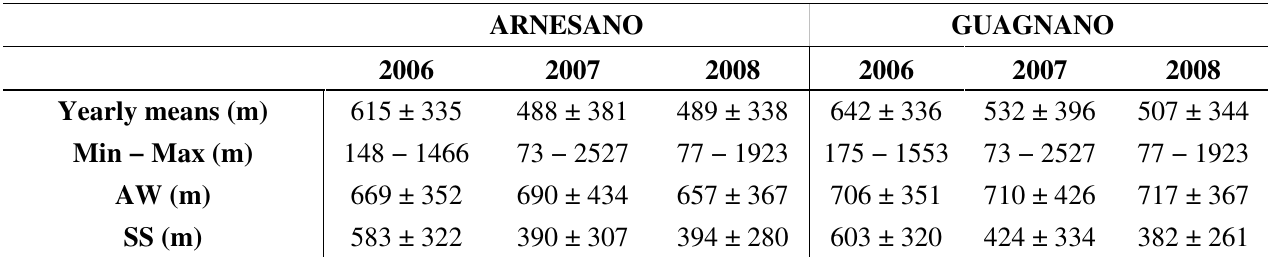
Table 4. Yearly means, minimum (Min), maximum (Max), autumn-winter (AW), and spring-summer (SS) mean values ± 1 SD deviation of mixing layer height mean values (Hmix (m)) at Arnesano and Guagnano in 2006, 2007, and